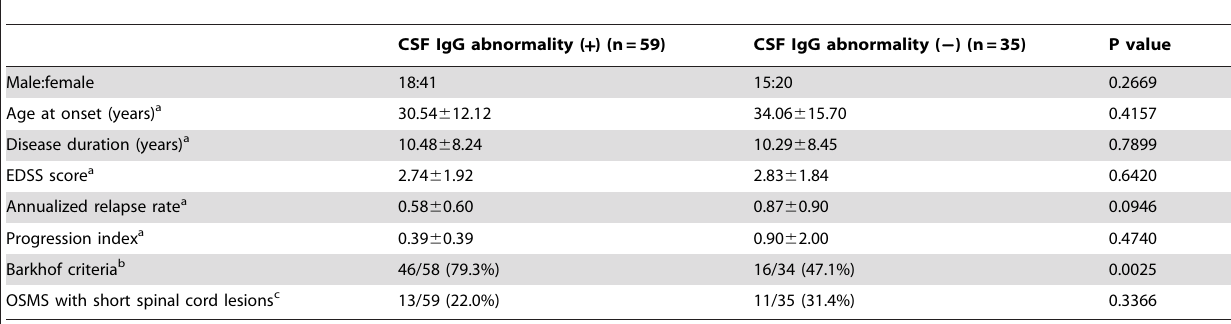
Table 1. Comparisons of the demographic features of MS patients according to the CSF IgG abnormality status.